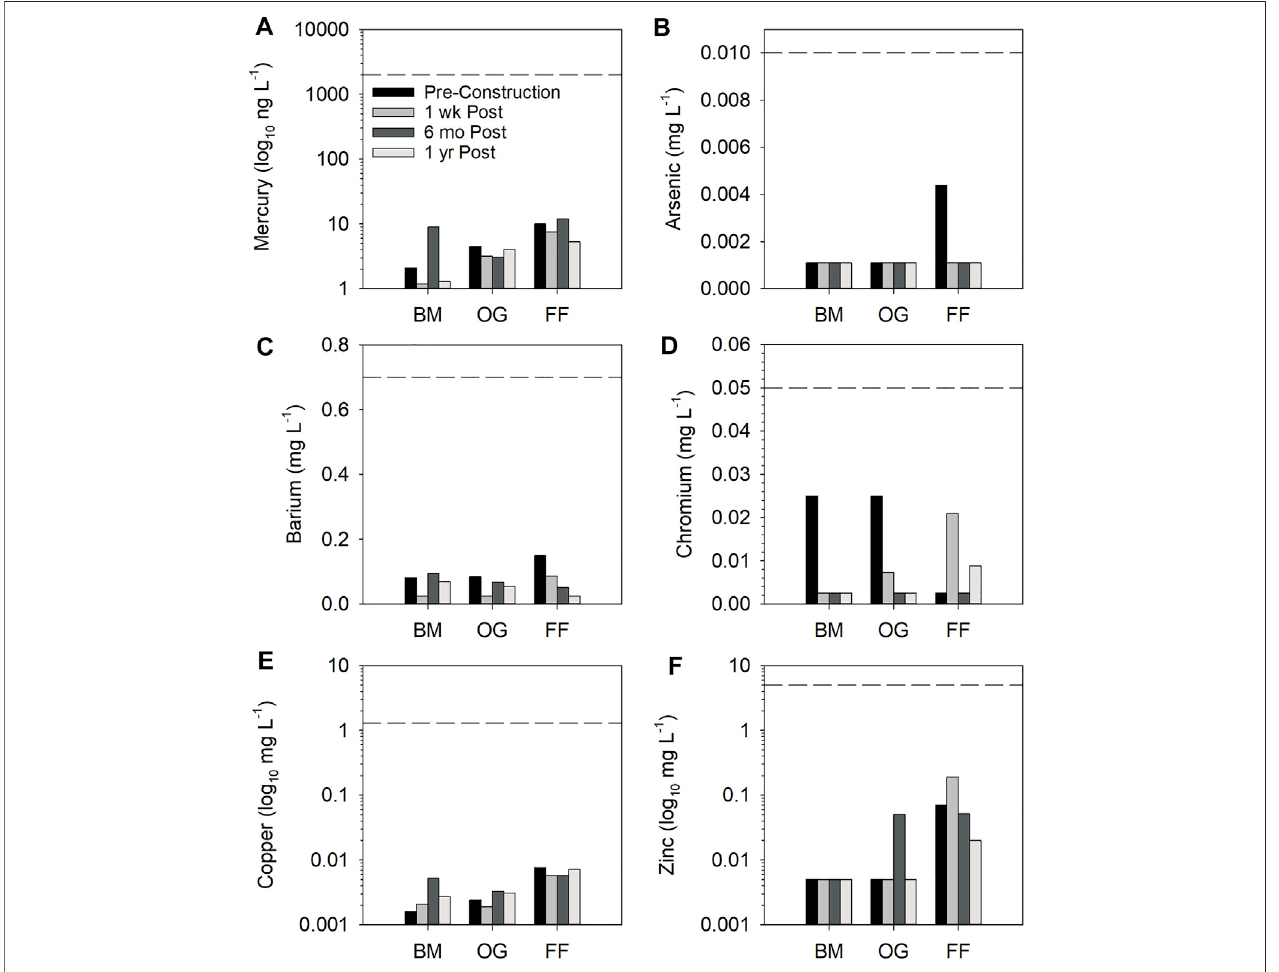
FIGURE 6 | Metals for pre-installation, 1-week, 6-month and 1-year post installation at Behind Mill 1 (BM), Oak Grove 2 (OG), and Fillmore Flex (FF). The black dashedlinerepresentsthedrinkingwaterstandardfromeithertheEPAorWHO,whicheverwasthesmallerofthetwostandardsforthegivenchemical.Thelegendin (A) applies to (B – F) . Note: y-axes for panel (A) , (E) , and (F) have logarithmic